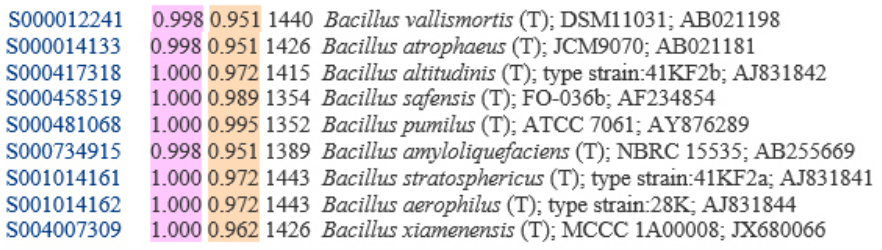
Figure 5. Sequence processing results.